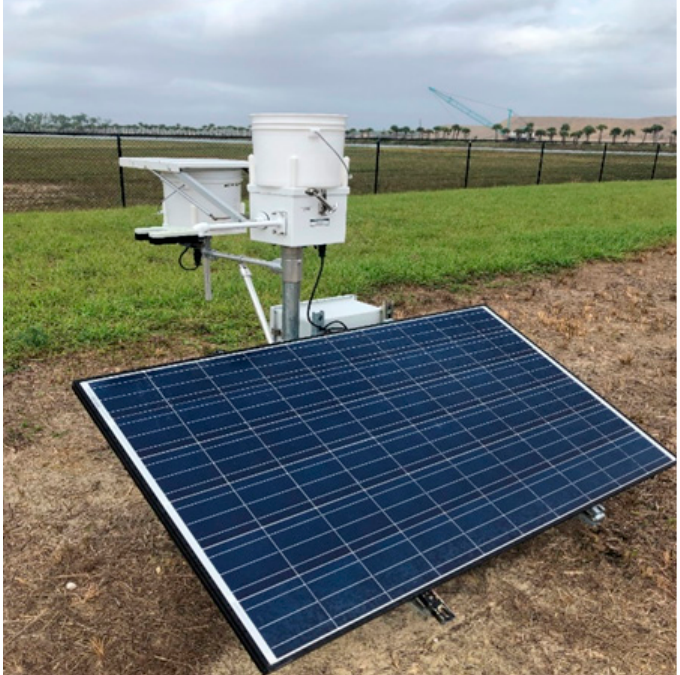
Figure 3. Closeup of the dry/wet sampling device. Note that the bucket used to gather dry fallout is open when it is not raining. The rain sensor closes the dry bucket and opens the wet bucket during rainfall. during